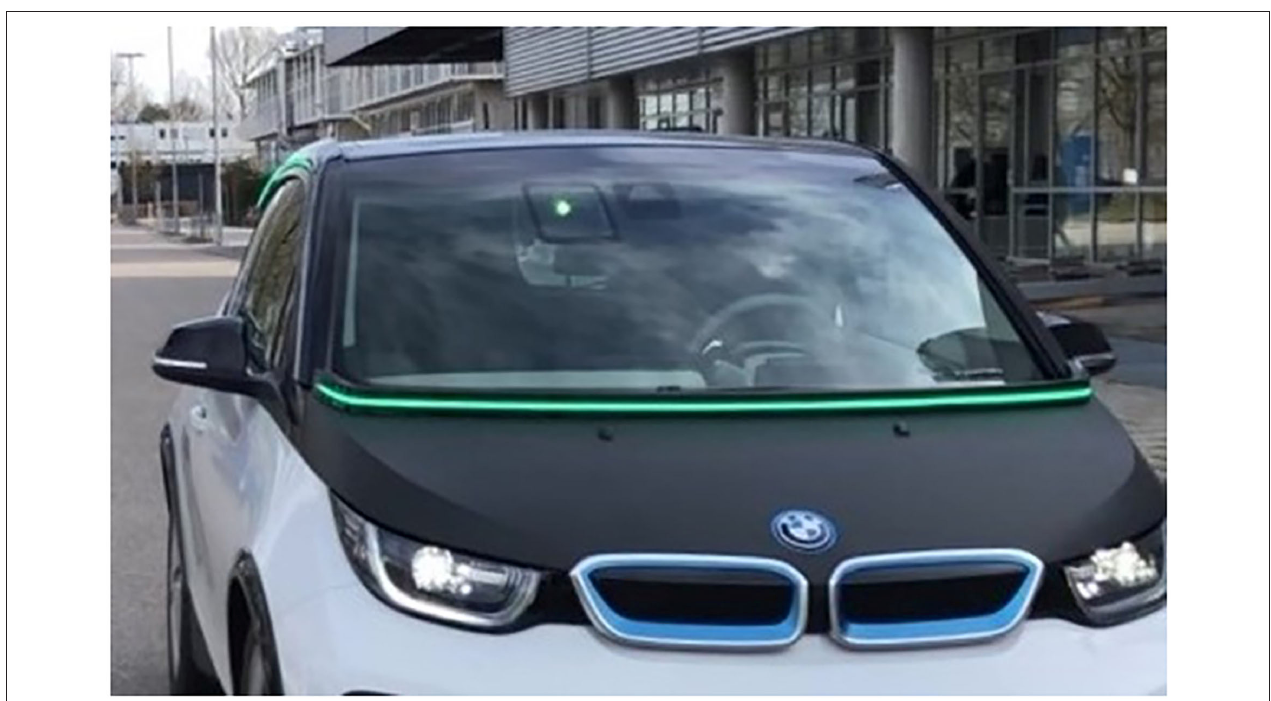
FIGURE 4 | eHMI concept combination of light-band and signal lamp communicating “I saw you” and “I’m letting you go